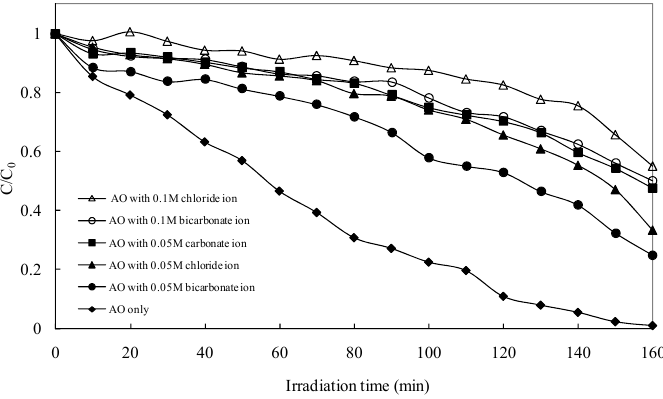
concentration 1.0 g L − 1 ; pH 8. 3